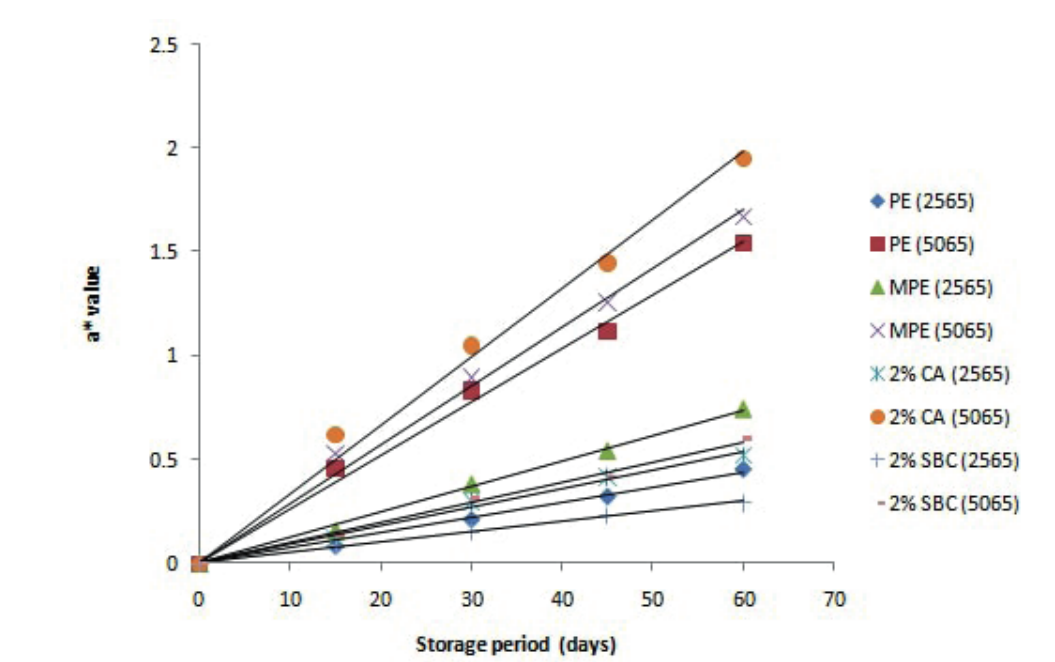
FIGURE 3 - Kinetics of colour (a*) degradation of rice extrudates prepared with and without incorporation of additives (citric acid and sodium bicarbonate at concentration of 2% each) packed and stored in different conditions (25°C and 50°C with 65% relative humidity) as a function of storage time for zero order model.